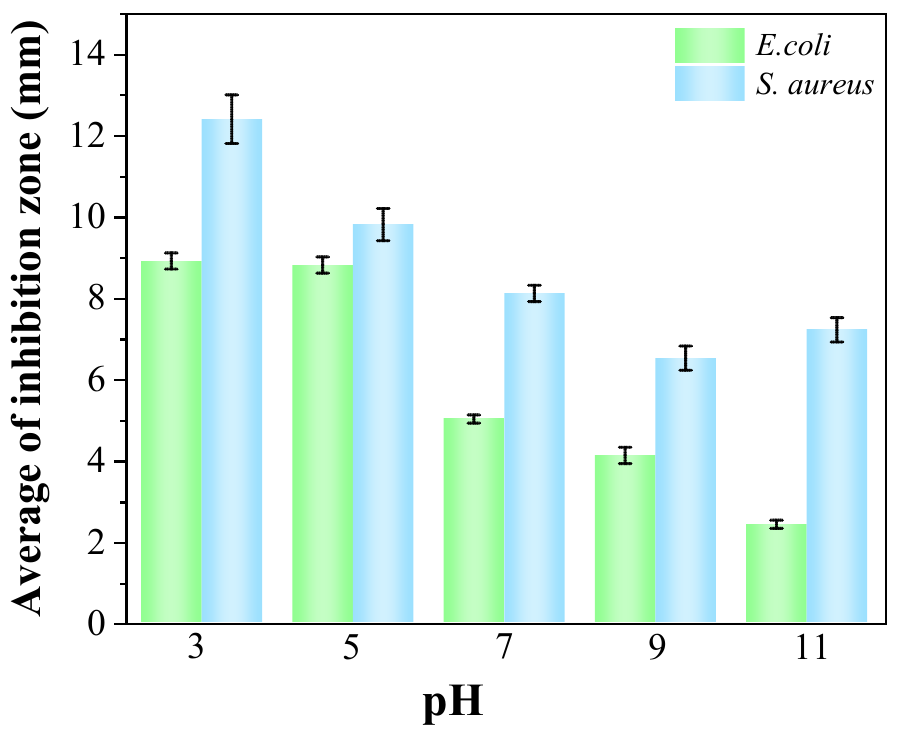
Figure 9. Antibacterial activity of ZnO@PPL/Cel-5 after treatment at different pH solutions. The water vapor transmission rate (WVTR) of samples was tested according to the reference [44]. As shown in Figure 10, one can see that the WVTA value of ZnO/Cel was about 46.12 g/(h m 2 mm). The high value is caused by the cellulose in the composite. The combination with PPL allows the WVTR value of ZnO@PPL/Cels to decrease and fall within the range 41.75–40.01 g/(h m 2 mm). The decrease is perhaps caused by the reduction of hydroxyl groups of cellulose, which are exploited to build hydrogen bonds with ZnO and PPL. Moreover, the high WVTR of the composite can provide a drying environment for the stored food and inhibit microbial growth.